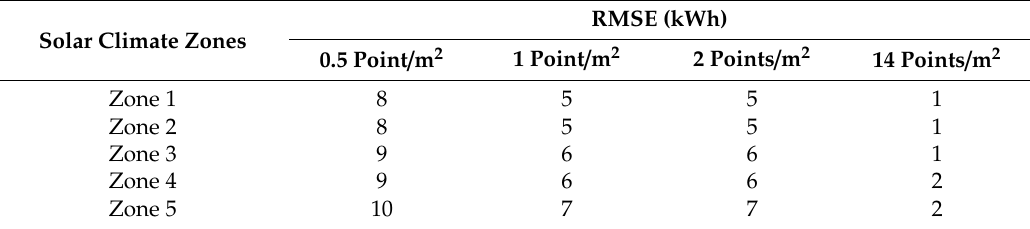
Table 16. Average daily PV energy production loss (kWh) due to the error in the estimation of the rooftop area for di ff erent point cloud densities: residential building with a gable roof of 100 m 2 .